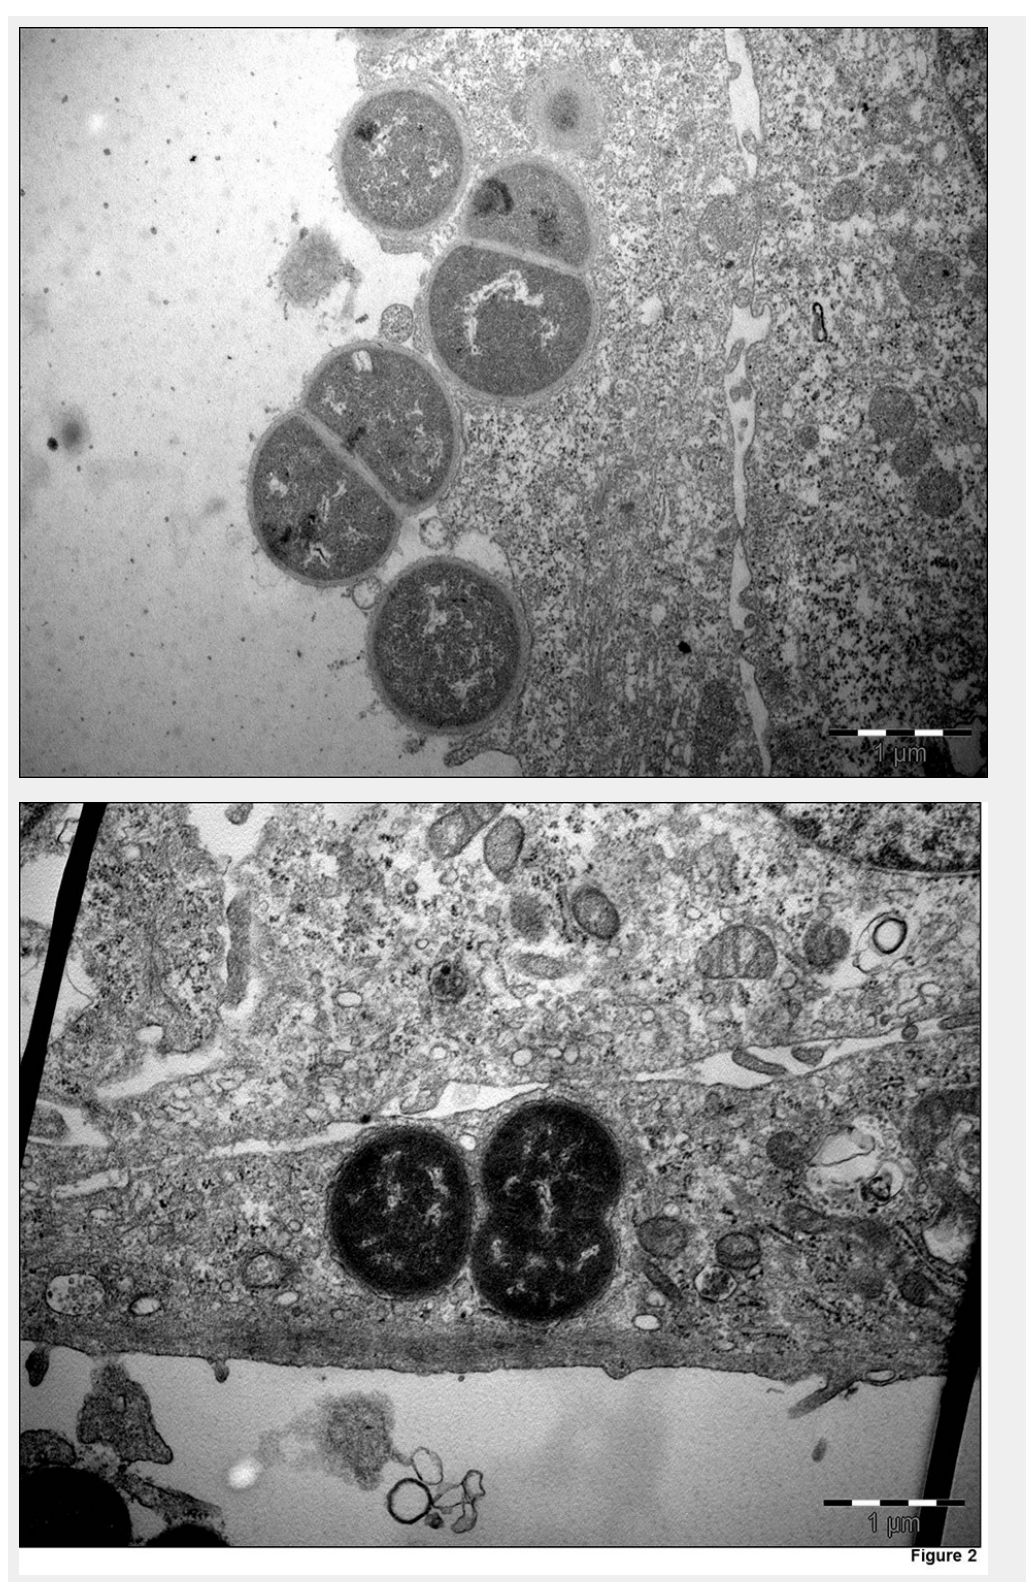
Figure 2 Transmission electron micrographs, demonstrating M. catarrhalis (strain 287) invasion in Detroit 526 pharyngeal